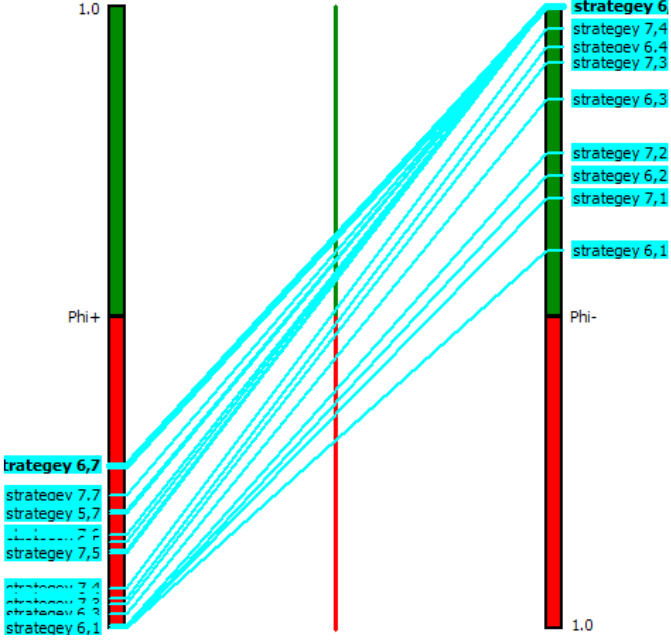
Figure 1. PROMETHEE I at Assumption